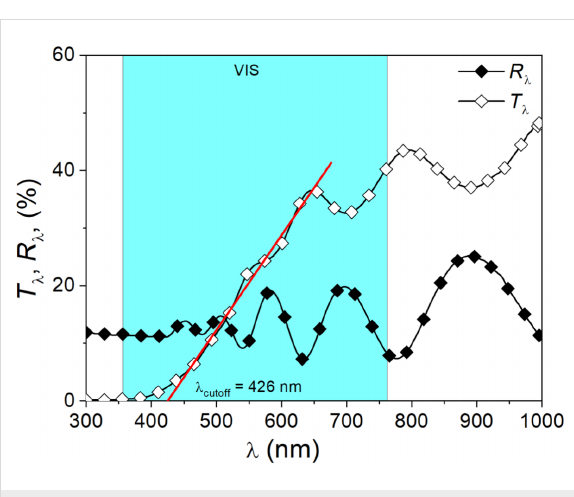
Figure 5: Transmission and reflection characteristics for gradient (Ti–Cu)Ox thin